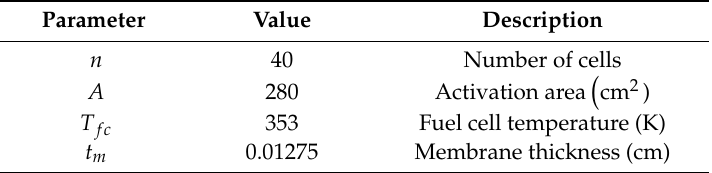
Table 1. The parameter used in fuel cell simulation.